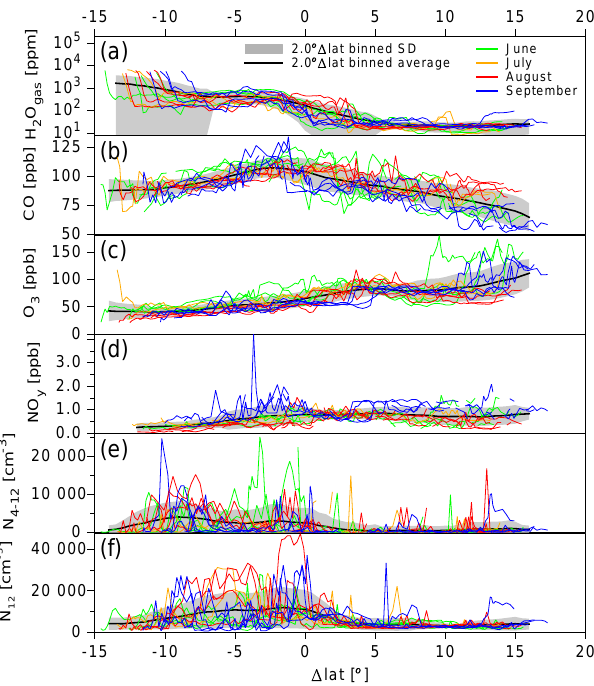
Figure 6. Profiles of trace gases (a–d) and aerosol particle number concentrations ( e and f , at STP 273.15K, 1013.25hPa) vs. relative latitude ( (cid:49) lat) coordinates for all flights. The colours indicate the flight month, the black line is the mean over all flights, and the grey shading indicates the 1 σ standard deviation around the mean (both calculated over moving 2 ◦ (cid:49) lat bins). Note the logarithmic scale in the water vapour plot in (a) .